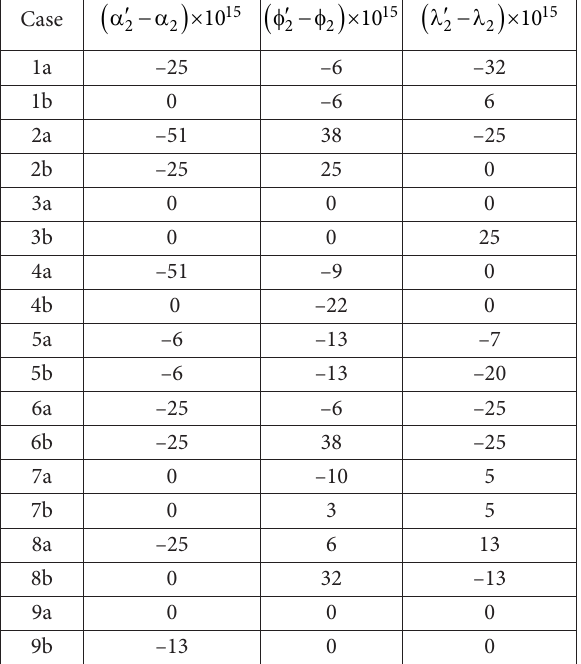
Table 4. Consistency of the inverse and direct problem. Values